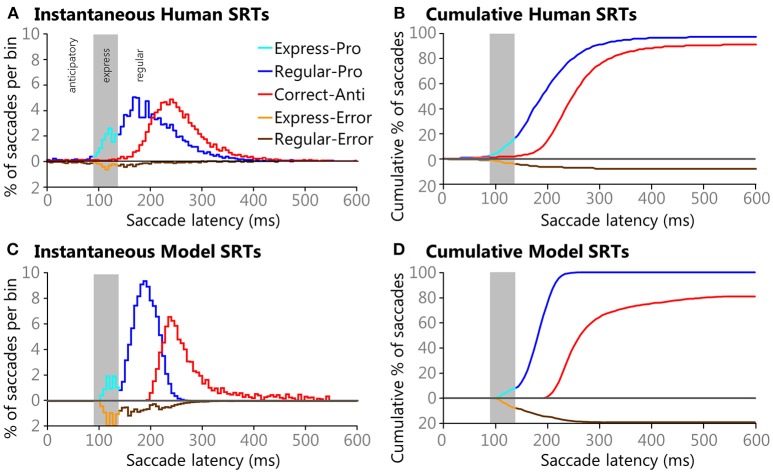
Histograms of Human (A,B) and Model (C,D) SRTs plotted using 6 ms bins. Direction errors are plotted below the zero line for ease of comparison. Gray areas in each pane indicate the express saccade window (90–138 ms). Instantaneous (A) and cumulative (B) histograms showing the percentages of saccades types and their latencies from healthy adults performing the pro- and anti-saccade tasks. Data is pooled from 74 participants between the ages of 18-39 that preformed a total of 14,493 saccades that fell into one of the five saccade types. Instantaneous (C) and cumulative (D) histograms showing percentages of saccades types and their latencies from the model. The model performed 118,098 trials, all of which had saccades that fell into one of the five saccade types.